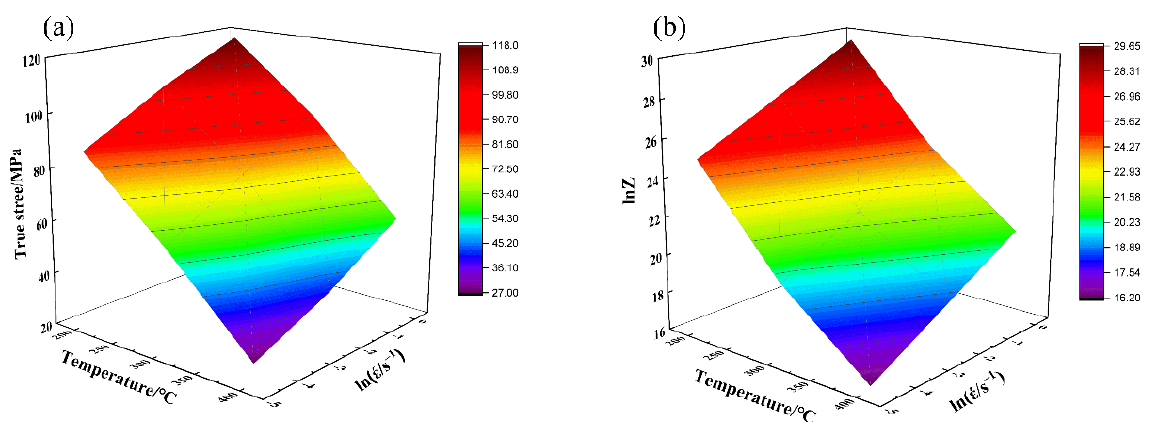
Figure 6. ( a ) Peak stress at different strain rates and deformation temperatures. ( b ) The values of lnZ under different deformation conditions.